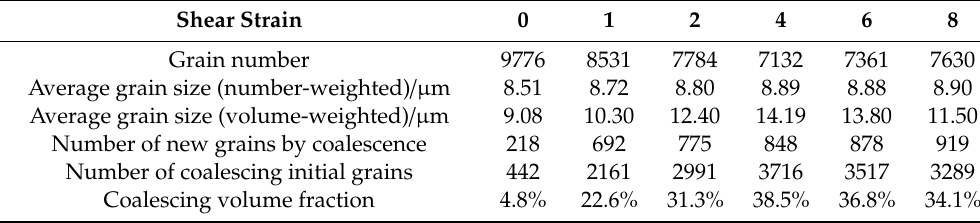
Figure 9. Texture evolution in {111} pole figures of a 3D polycrystal with shear-type initial texture (a) at shears of 0 ( a ), 1 ( b ), 2 ( c ), 6 ( d ), 6 ( e ), and 8 ( f ). (SP indicates the shear plane, and the arrow is orientated in the shear direction; SPN is the shear plane normal). Table 3. Grain coalescence analysis results for the polycrystal with shear-type initial